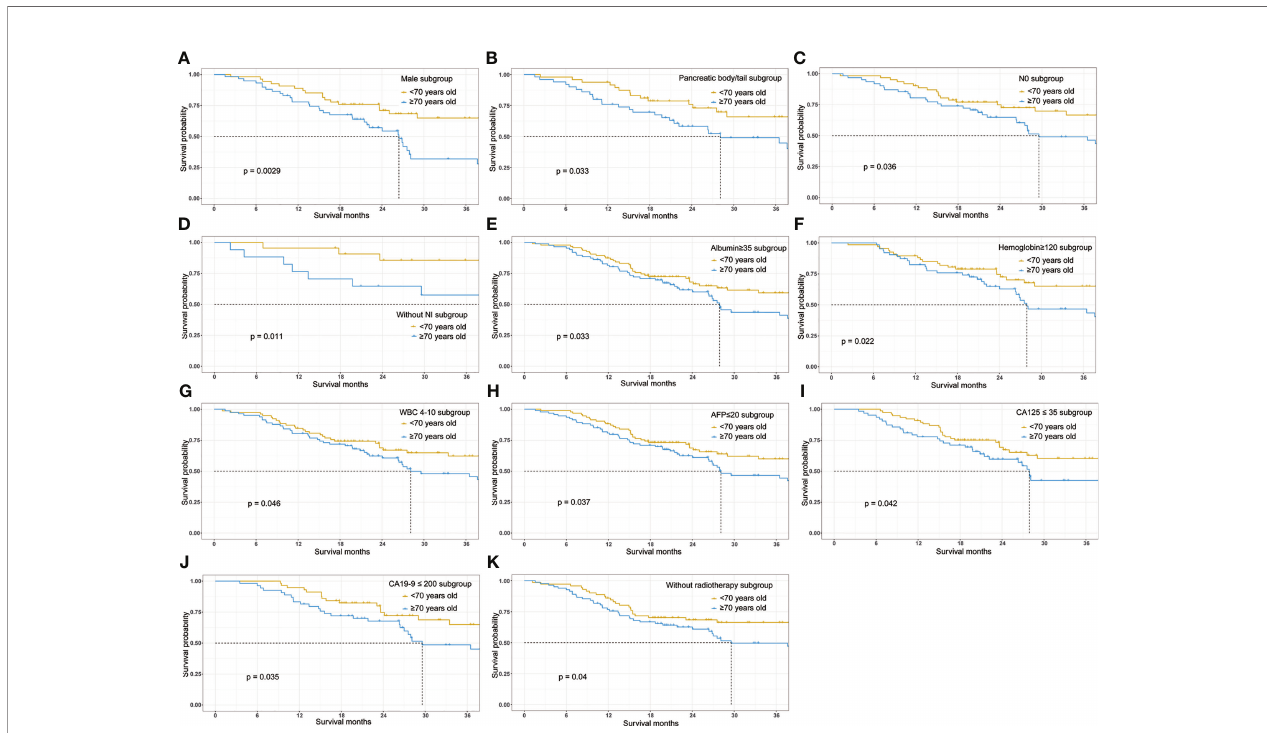
FIGURE 4 | Overall survival Kaplan-Meier survival curves strati fi ed by age ( ≥ 70 vs <70) in the major subgroups. (A) Survival curve strati fi ed by age in male patients. (B) Survival curve strati fi ed by age in patients with pancreatic body/tail cancer. (C) Survival curve strati fi ed by age in patients without lymphatic metastasis. (D) Survival curve strati fi ed by age in patients without perineural invasion. (E) Survival curve strati fi ed by age in patients with serum albumin higher than 35g/L. (F) Survival curve strati fi ed by age in patients with hemoglobin higher than 120g/L. (G) Survival curve strati fi ed by age in patients with white cell count (WBC) between 4 and 10×109/L. (H) Survival curve strati fi ed by age in patients with AFP lower than 20ng/ml. (I) Survival curve strati fi ed by age in patients with CA125 lower than 35 ng/ml. (J) Survival curve strati fi ed by age in patients with CA19-9 lower than 200U/ml. (K) Survival curve strati fi ed by age in patients who didn ’ t receive adjuvant radiotherapy following